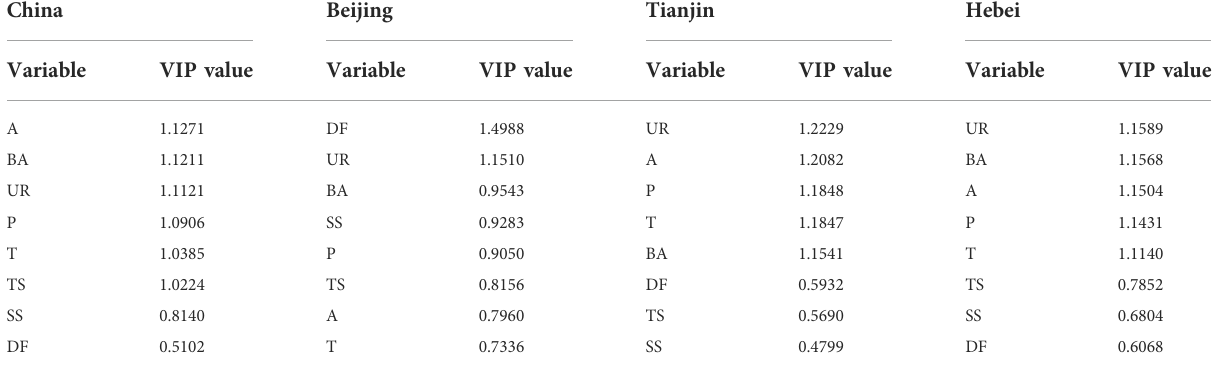
TABLE 5 VIP of variables in China, Beijing, Tianjin and